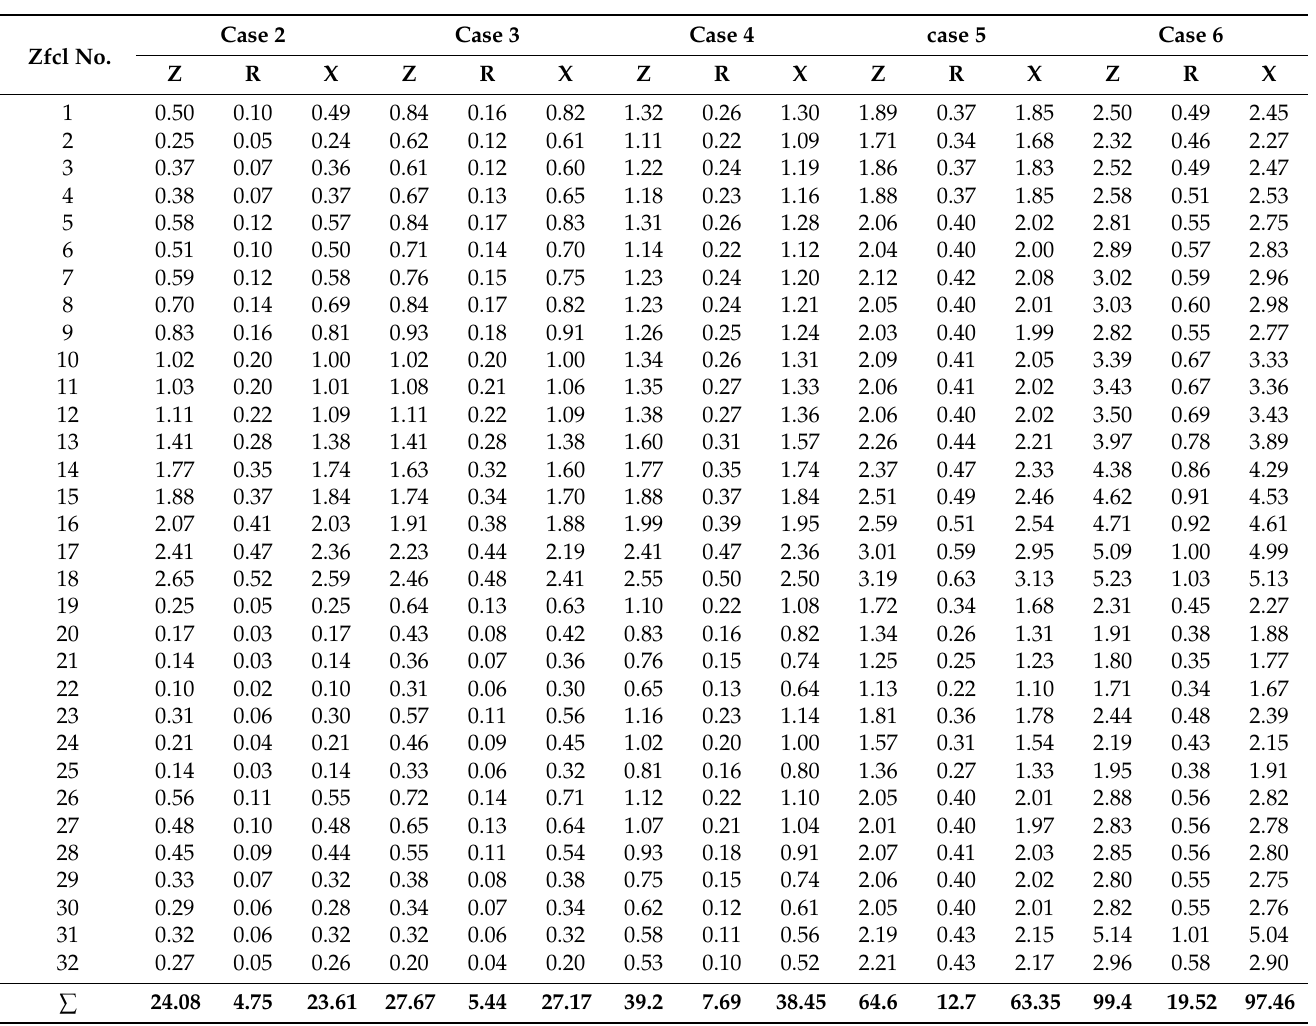
Table 1. Optimized Z fcl (ohms) parameters using the hybrid GWO-PSO algorithm.